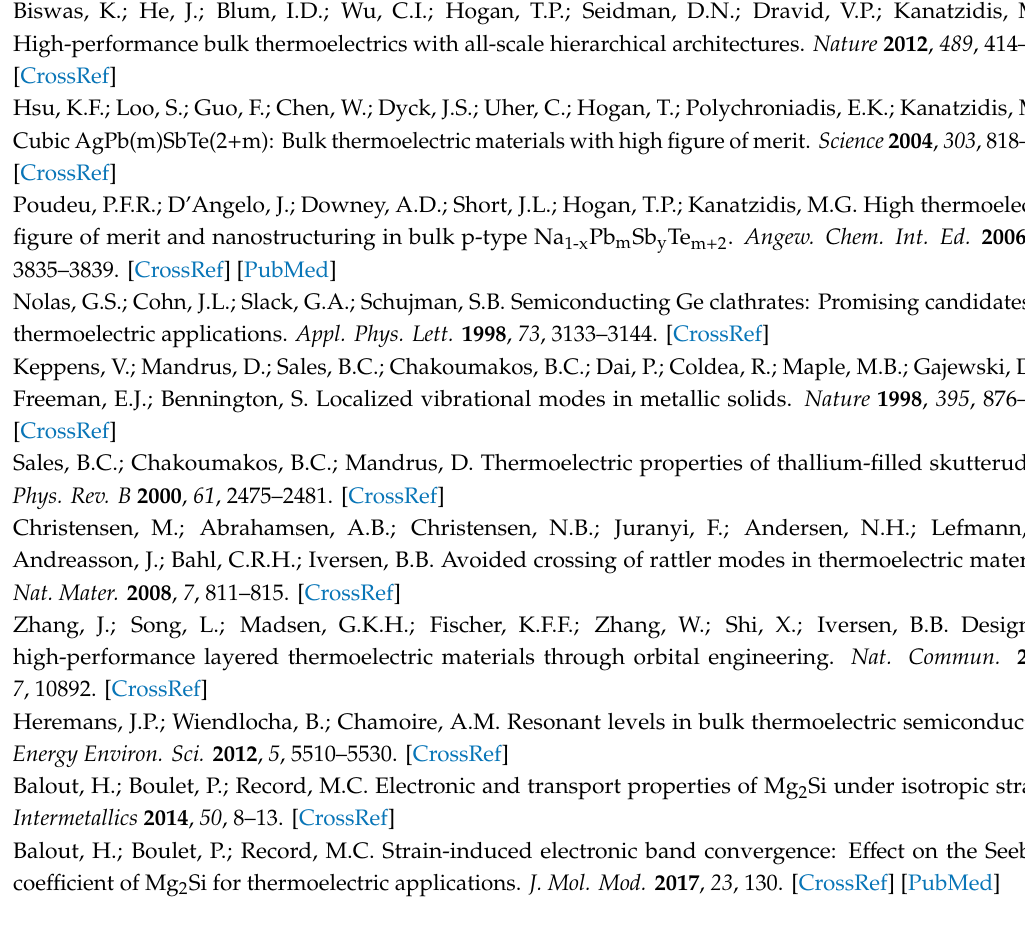
Table S1: Topological properties of the electron density at the bond critical points of the BaRh 2 Ge 4 X 6 (X = S, Se, Te) and BaRh 2 Ge 4 S 4 Te 2 compounds. r in e / bohr 3 , Dr in e / bohr 5 , G and V in Ry / bohr 3 , H / r and G / r in Ry / e, R, R 1 and R 2 in Bohr, q in degree. Figure S1: Structure of the Ba 2 Rh 4 Ge 4 compound. The barium atom (big, green balls) is surrounded by six germanium ones (purple), forming an inverted bipyramid (rectangular trapezoprism). The rhodium atom (kaki) is at the centre of a tetrahedron formed by four germanium atoms. Table S2: Atomic charges borne by the Ba, Rh and Ge atoms in the Ba 2 Rh 4 Ge 4